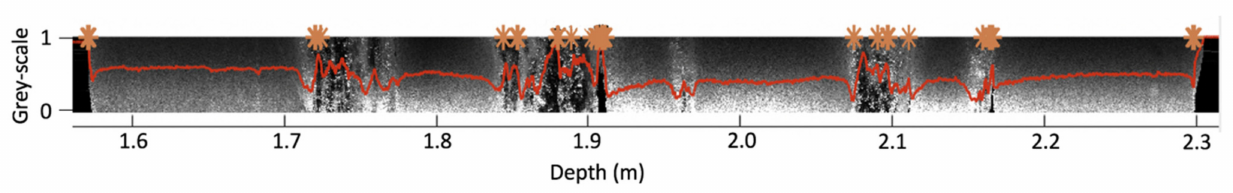
Figure 1. Line scanned image from the Mount Siple firn core corresponding to depth (1.6–2.3 m), highlighting the presence of melt layers (marked by stars) overlain by a plot of the grey-scale values